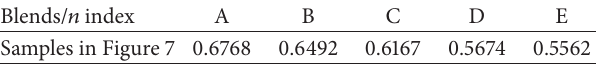
Table 2: The non-Newtonian index of blends in Figure 7. Blends/ 𝑛 index A B C D E Samples in Figure 7 0.6768 0.6492 0.6167 0.5674